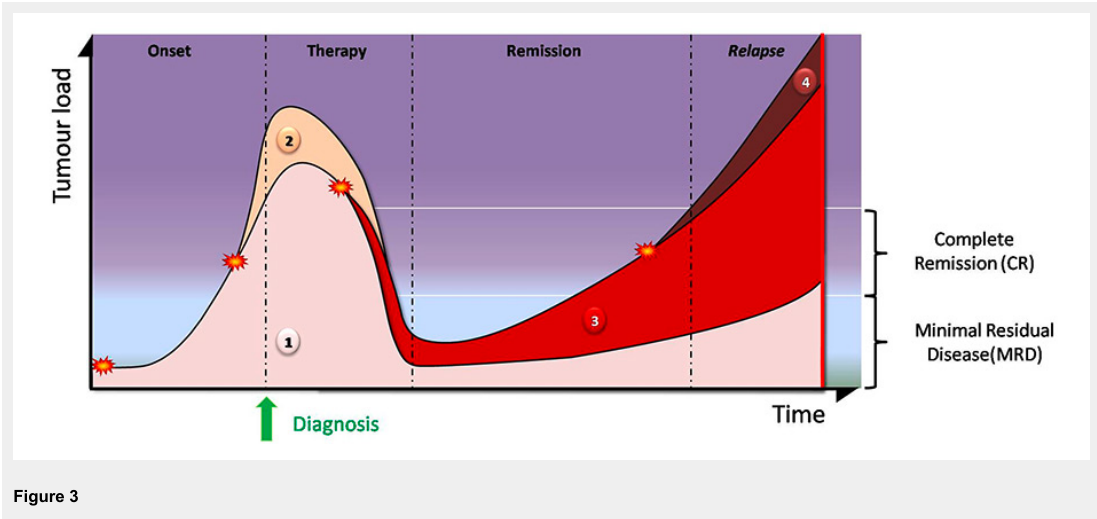
Figure 3 Clonal evolution during chemotherapy. Tumour clones derive from somatic mutations (stars). The original parent clone (1) can give rise to subclones (2, 4). Additional mutations due to chemotherapy/radiotherapy can also trigger the development of new subclones (3). Therapy eliminates some clones (2) but some others (1, 3) survive and are detected as minimal residual disease. Clonal composition may be very different between the initial diagnosis and after